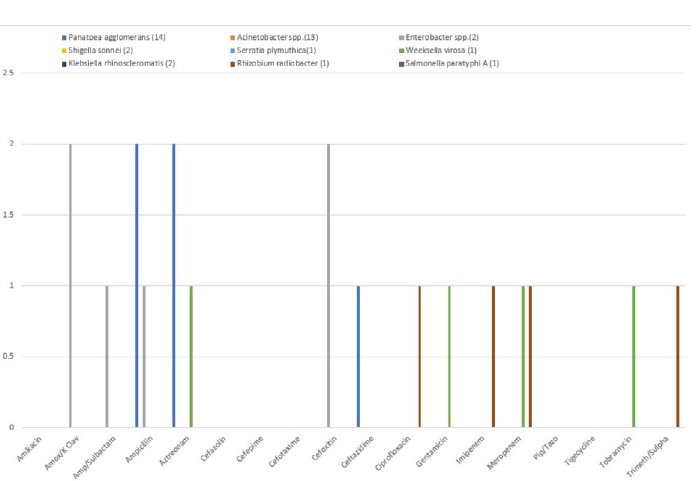
Fig. 3. Antibiotic susceptibility pattern of gram-negative